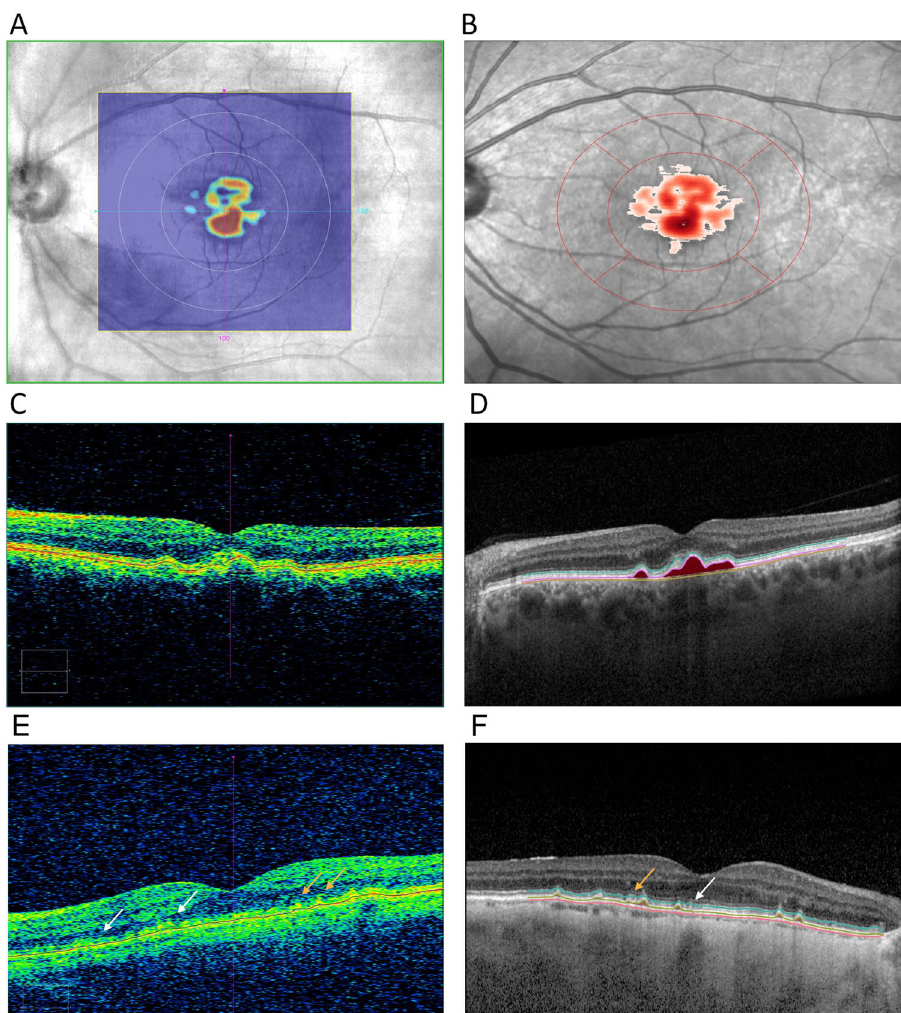
Figure 1. Comparison of Drusen segmentation of the same eye with iAMD, assessed with Cirrus (( A ) enface projection, ( C ) foveolar B-scan) and Spectralis OCT (( B ) enface projection, ( D ) foveolar B-scan), showing similar identification. ( E ) (Cirrus) and ( F ) (Spectralis) showing failure to detect (white arrows) or adequately segment (orange arrows) RPE elevations by automated segmentation algorithms in a corresponding macular